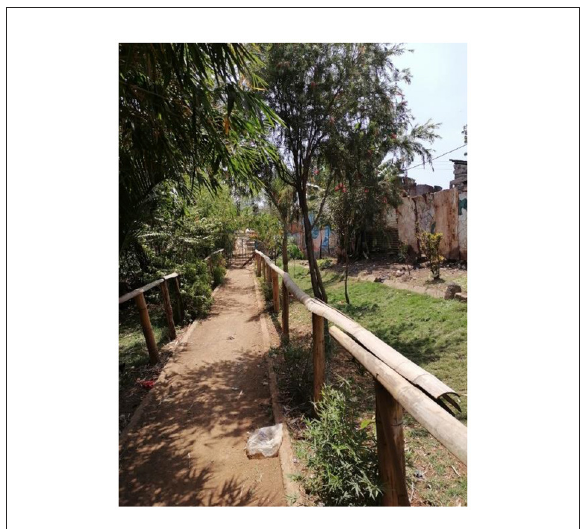
FIGURE4 Korogocho People’s park. Source: Muchiri and Opiyo (2022).